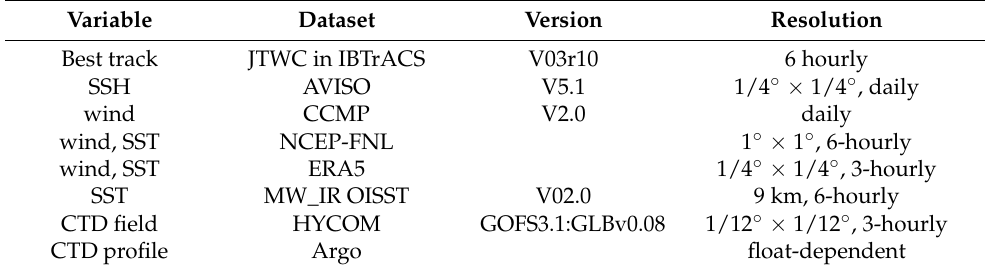
Table 1. Multiplatform datasets used in present study. CTD represents conductivity (or salinity), temperature and